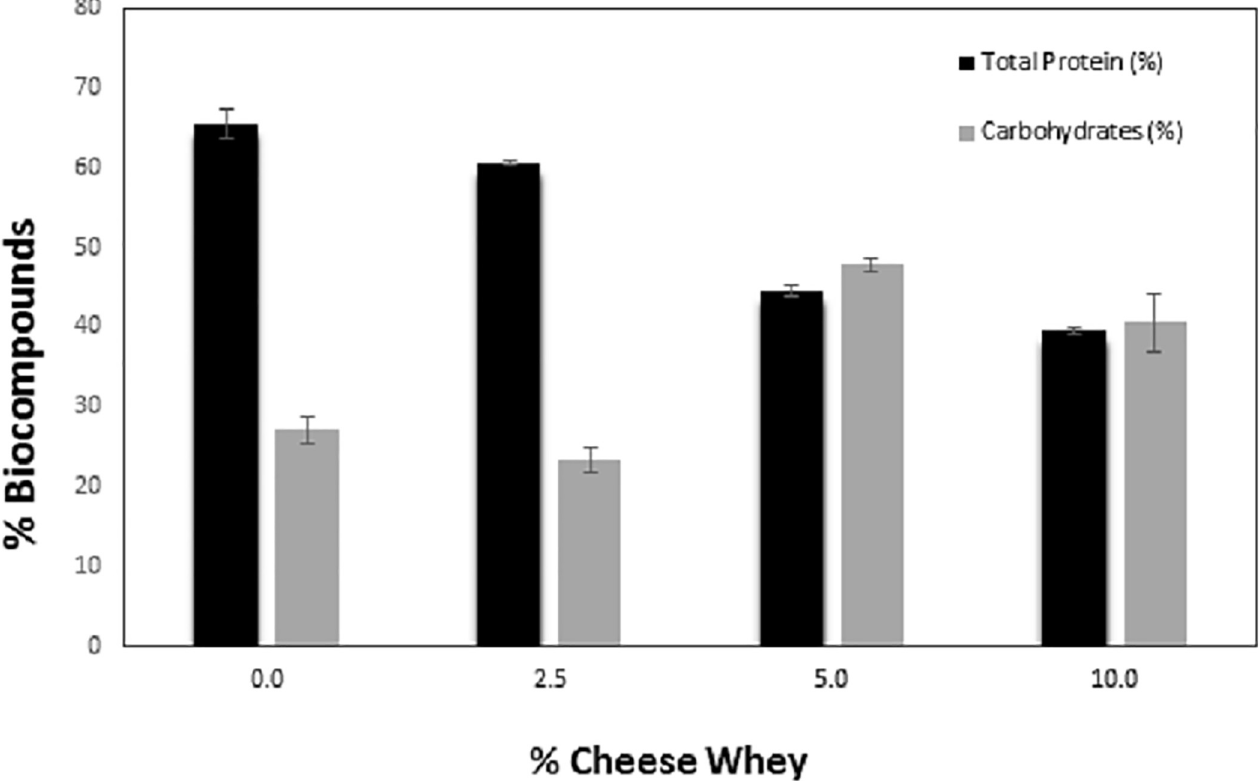
Fig 4. Influence of the whey percentage on the synthesis of carbohydrates and proteins by S . platensis . The error bars represent the standard deviations (n = 3).